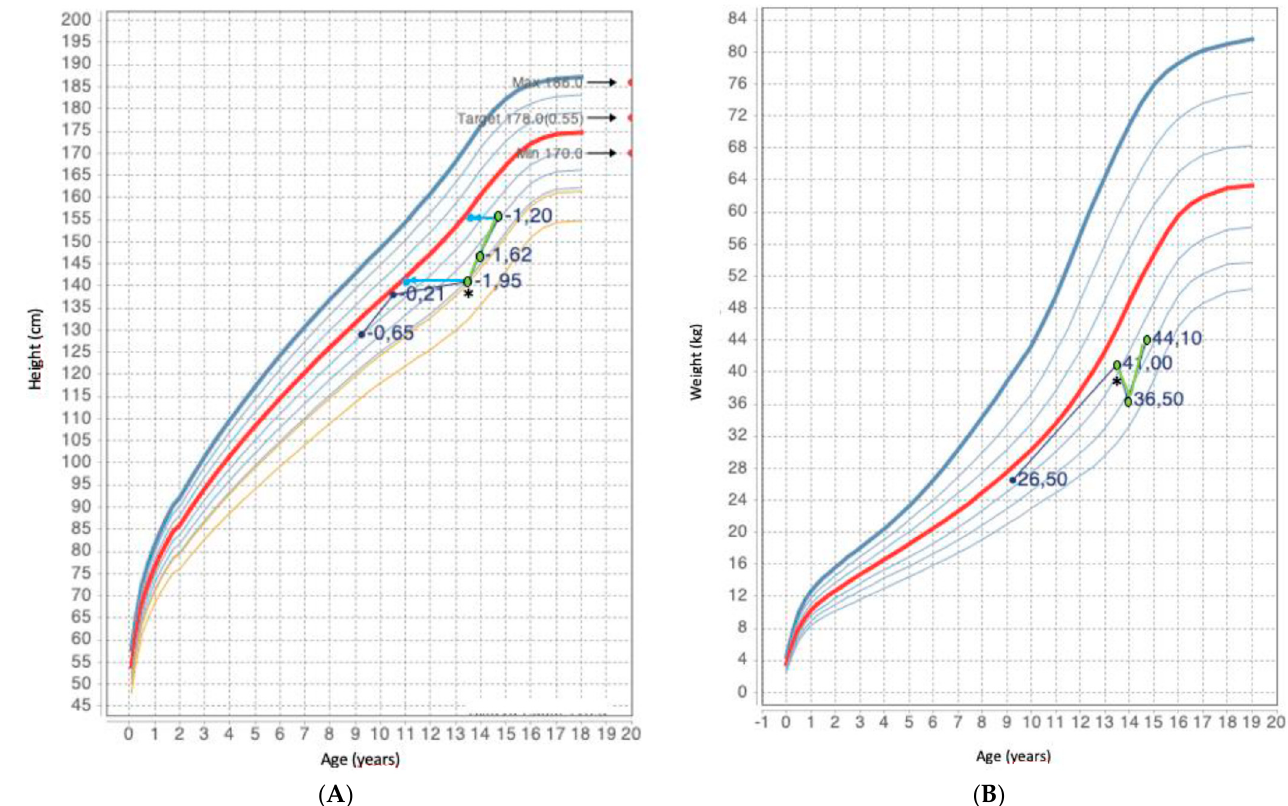
Figure 2. ( A , B ). Height and weight of the reported patient. Green spots represent height and weight at diagnosis, and at follow up in the endocrinology department. Dark blue spots show previous height and weight measurements based on pediatrician growth monitoring. Light blue spots represent the height projected based on the bone age, while light blue arrows reflect the difference with chronological age. Black asterisk indicates initiation of levothyroxine treatment at diagnosis. The red spots and marked interval correspond to the mid target height +/ − 2 SDS. Considering the extreme elevation of TSH, according to the internal protocol, hypothalamic-pituitary magnetic resonance imaging (MRI) was performed and revealed pituitary hyperplasia (diameters of 16 × 12 × 16 mm, with convex upper margin) (Figure 3).